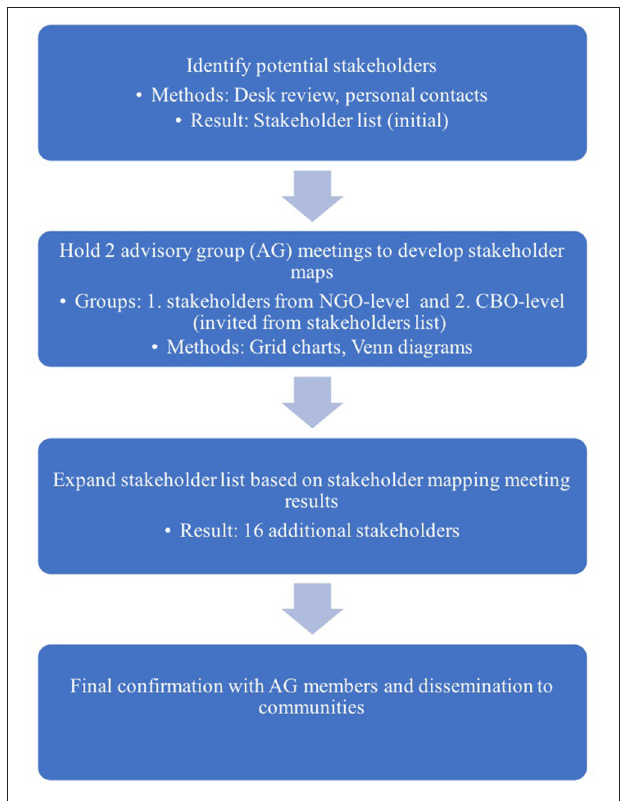
FIGURE 1 | Steps conducted for stakeholder